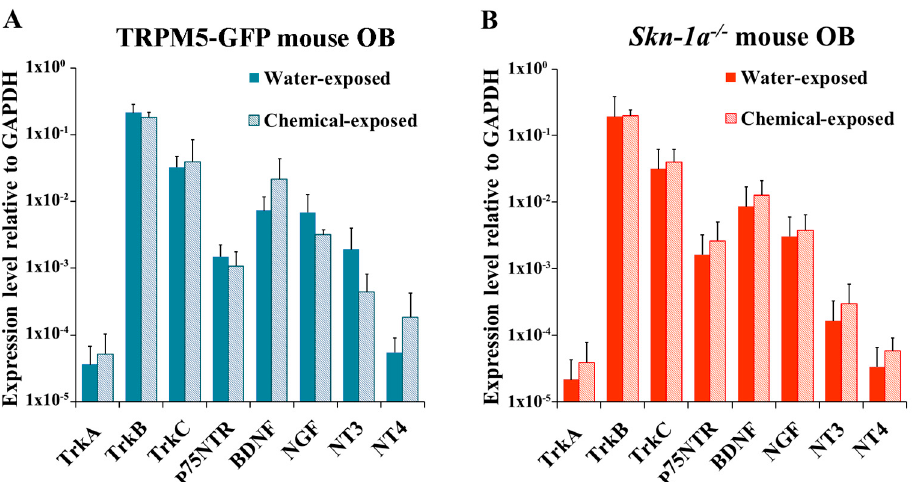
Figure 5. NT and NTR expression levels in the OB of chemical- or vehicle (water)-exposed TRPM5-GFP and Skn-1 a − / − mice. The plots show the relative gene expression levels obtained by qPCR analysis using total RNA extracted from the OBs. ( A ) TRPM5-GFP mice exposed to vehicle (water) or chemicals. No significant differences were detected between the two groups ( p > 0.05, two-tailed independent t -test, n = 6). ( B ) Skn-1a − / − mice exposed to vehicle (water) or chemicals. No significant difference was observed between the two groups (p > 0.05, two-tailed independent t -test, n = 6), although the NT and NTR expression levels trended higher in the chemical-exposed group. The bar graphs represent the mean ±